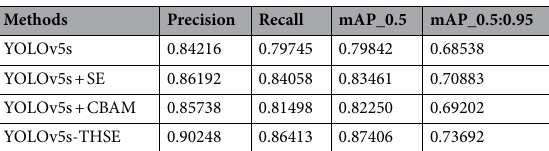
Table 5. Comparison of indicators of different models on small target data